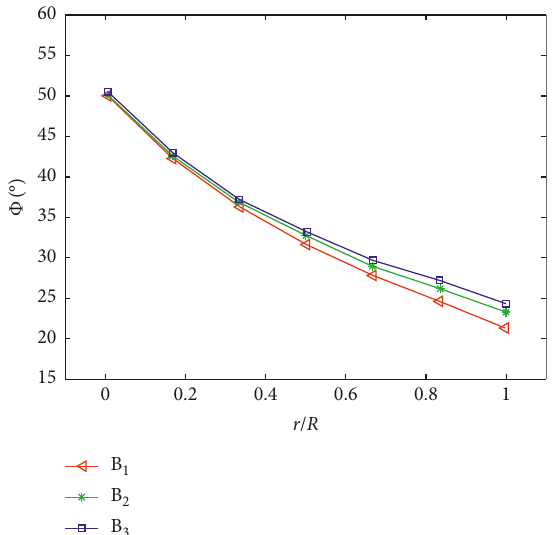
Figure 2: Blade seating angle of each section.